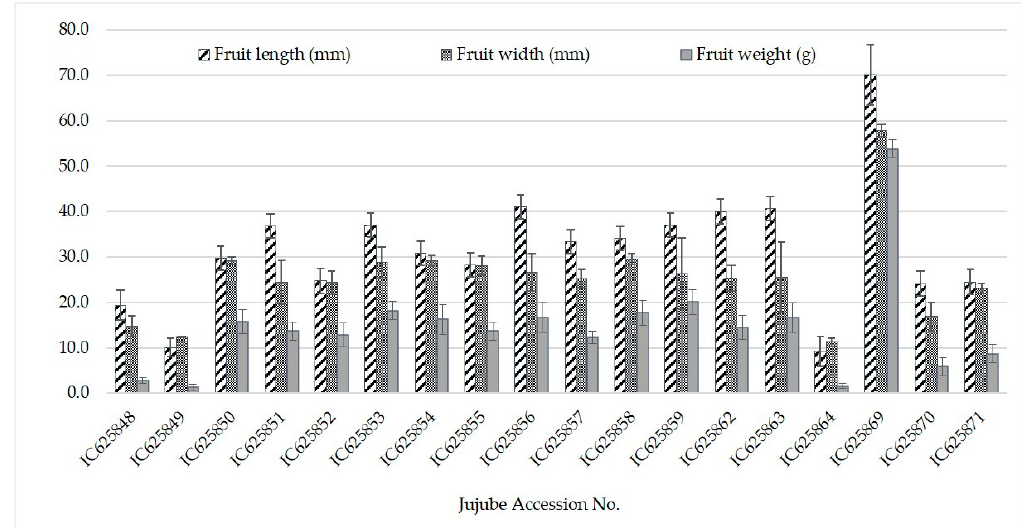
Figure 1. Physical fruit characteristics (fruit length, mm; fruit width, mm; and fruit weight, g) of jujube fruits ( n = 40) for each of the 18 genotypes of jujube tree studied in the two-year study. Mean values ± sd, n = 40. Table 2. Mean sum of squares for different biochemical parameters of the fruits of the 18 genotypes of jujube studied during two-years of